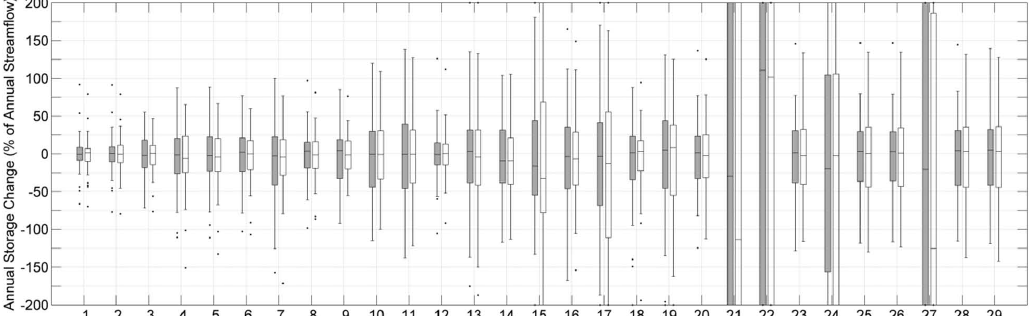
Fig. 11. Ranges of simulated annual storage change as a percentage of annual streamflow observations for VIC (gray boxes) and VIC-SIMGM (white boxes). The central mark in each box indicates the median, and the edges of the box are the 25th and 75th percentiles. Whiskers extend to a maximum of ∼ 2.7 standard deviations from the median, and outliers are indicated by